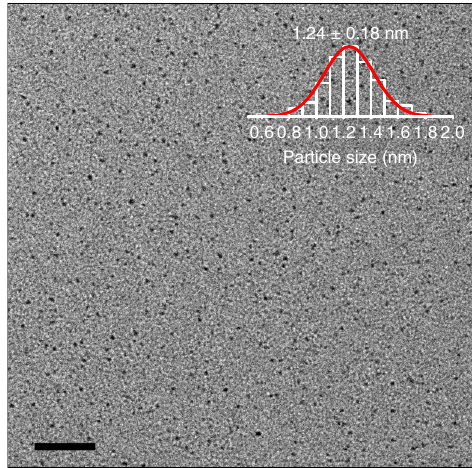
Fig. 4 Particle size of intermediates. TEM image of the intermediates obtained after NaBH 4 addition to the reaction mixture, when the mixture became clear and colorless. Scale bar: 20 nm. The overlaid inset shows a particle size histogram and the corresponding Gaussian fi